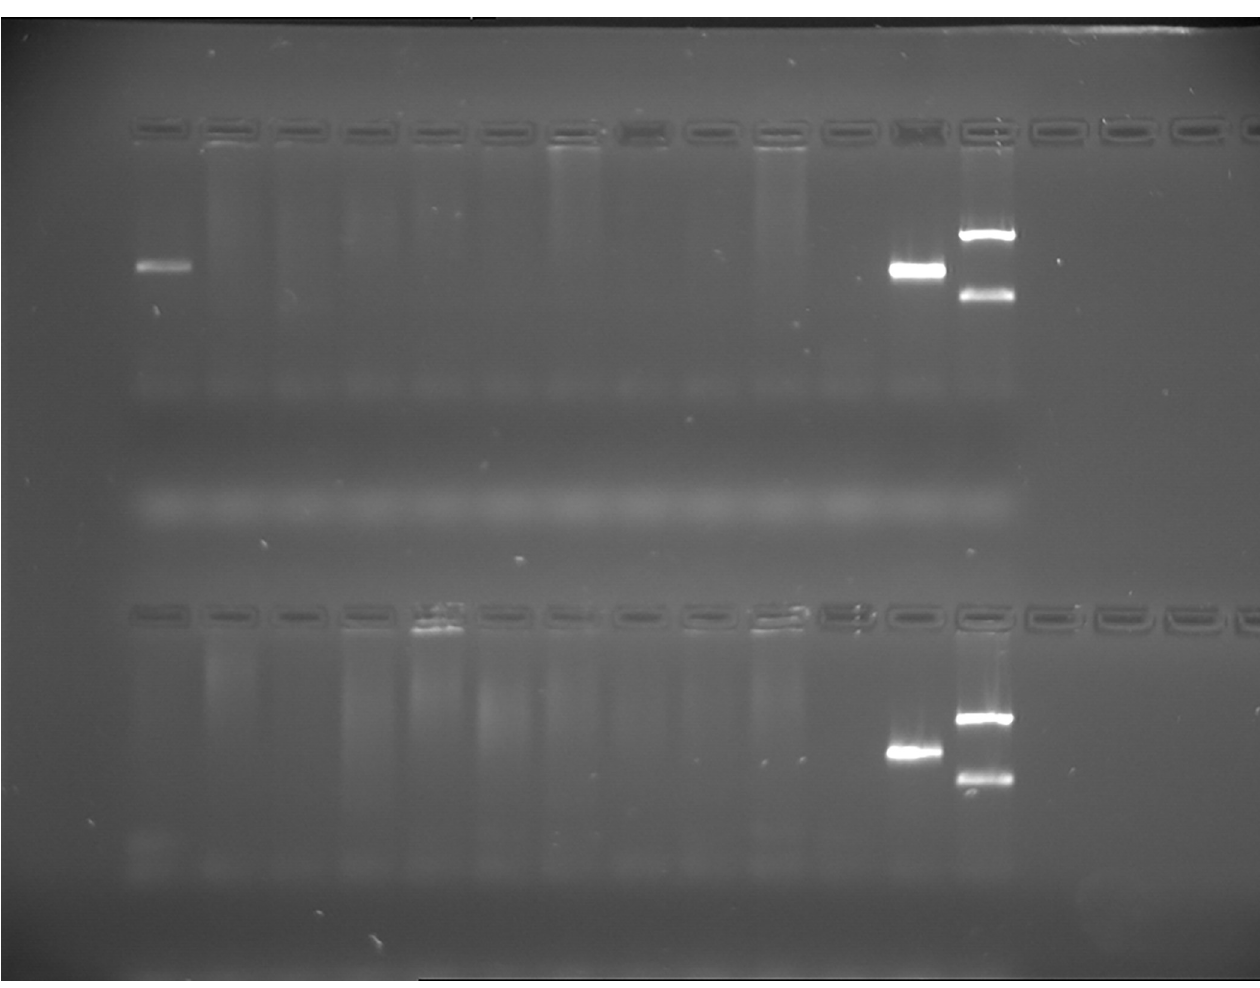
PLOS ONE | https://doi.org/10.1371/journal.pone.0270177 August 11,